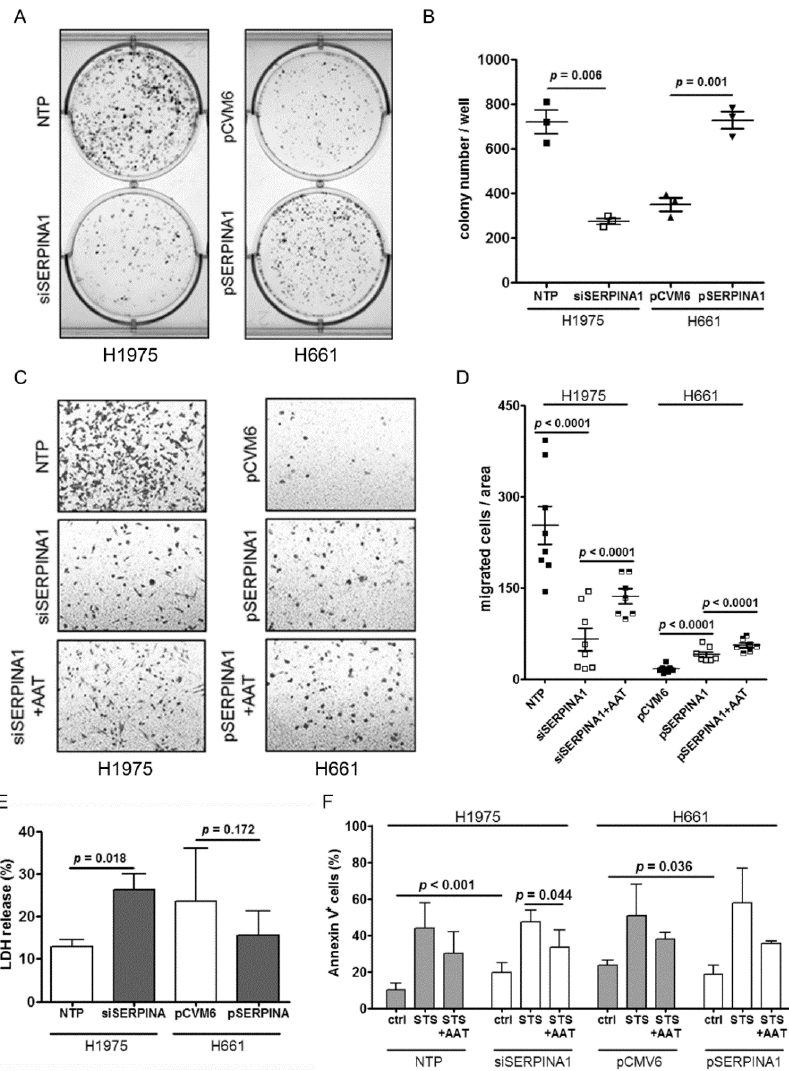
Figure 6. Silencing or overexpressing SERPINA1 gene affects cancer cell colony formation, migration, viability and resistance to apoptosis. ( A ) and ( B ) Cancer colony number per area in SERPINA1 siRNA-treated H1975 cells or SERPINA1 overexpressing H661 cells. Each point represents a separate experiment. Data presented as mean ± SD. p < 0.05 was considered as significant. ( C ) and ( D ) The migratory abilities of H1975 cells after SERPINA1 -knockdown and H661 cells after SERPINA1 overexpression with / without addition of AAT. The graphs indicate data from three independent experiments as mean ± SD. p < 0.05 was considered as significant. ( E ) LDH release rate after silencing or overexpression of SERPINA1 . H1975 and H661 cells were treated with 50 nM STS alone or together with AAT (2 mg / mL) for 18 h after SERPINA1 knockout or overexpression, respectively. All experiments were performed in duplicates and repeated three times. Each point represents a mean ± SD. p < 0.05 was considered as significant. ( F ) H1975 and H661 cells were treated with 50 nM STS alone or together with AAT (2 mg/mL) for 18 h. Annexin V surface expression was determined by flow cytometry. All experiments were performed in duplicates and repeated three times. Each point represents a mean ± SD. p < 0.05 was considered as significant. NTP: non-target-pool siRNA and pCVM6 as control vector.